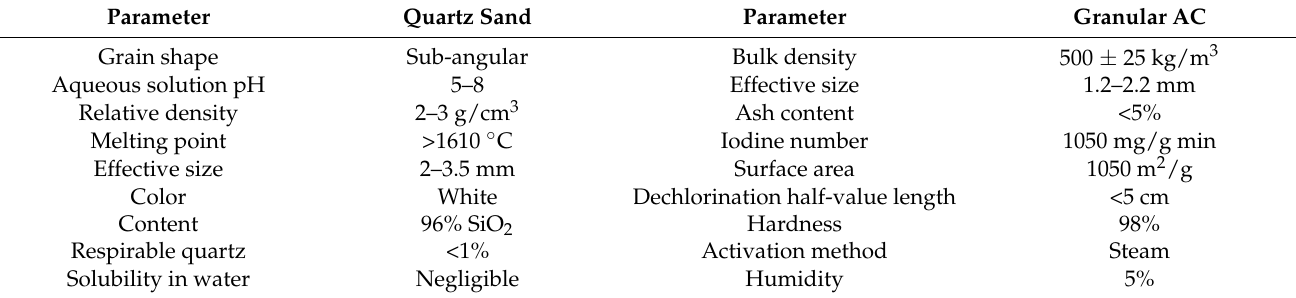
Table 1. Physicochemical properties of quartz sand and granular activated